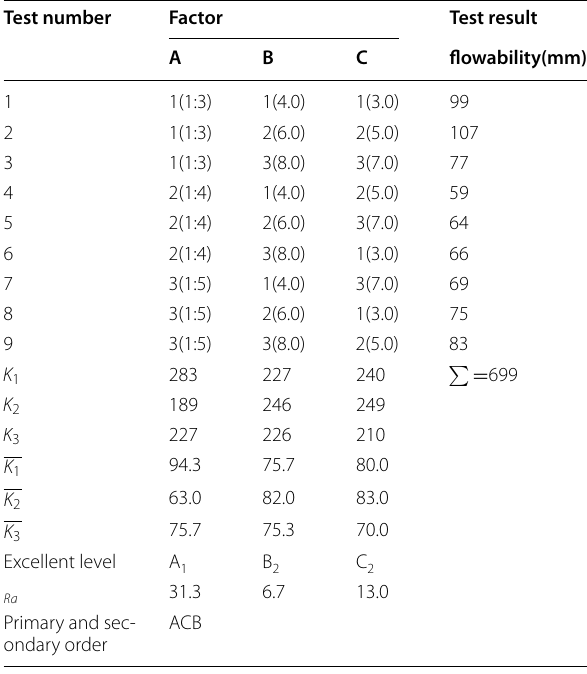
Table 10 Analysis of mortar